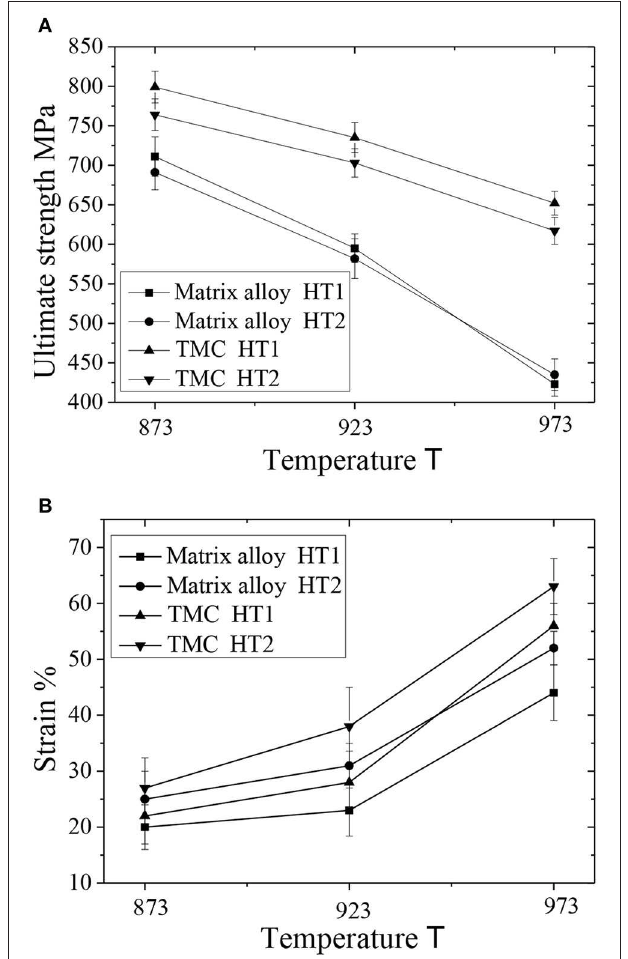
FIGURE 5 | High temperature tensile properties of matrix alloy and TMCs after heat treatment. (A) Ultimate strength. (B) Strain.